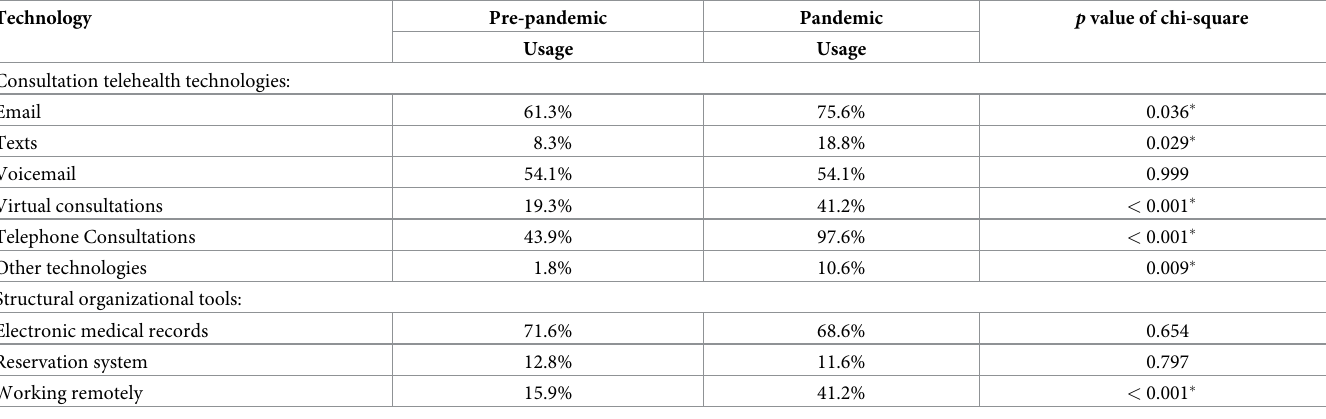
Table 2. Telehealth technology usage pre-pandemic and during the COVID-19 pandemic ( n = 114). Technology Pre-pandemic Usage Usage